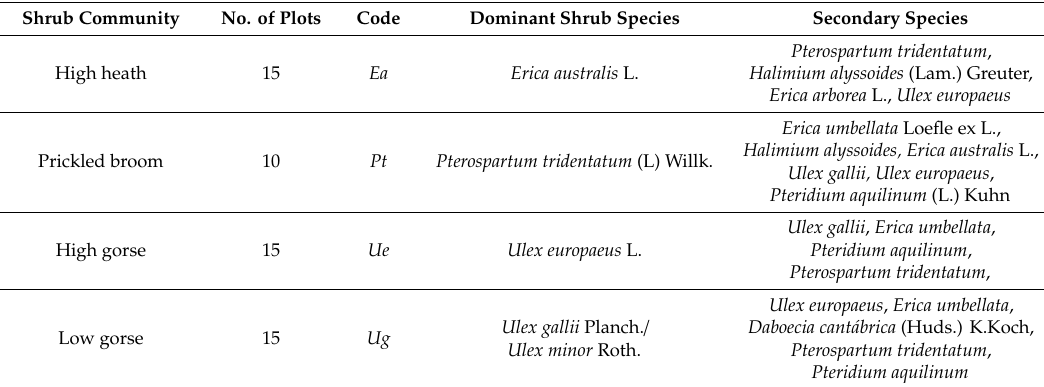
Table 1. Shrub community, number of plots, codes, and dominant and secondary species. Shrub